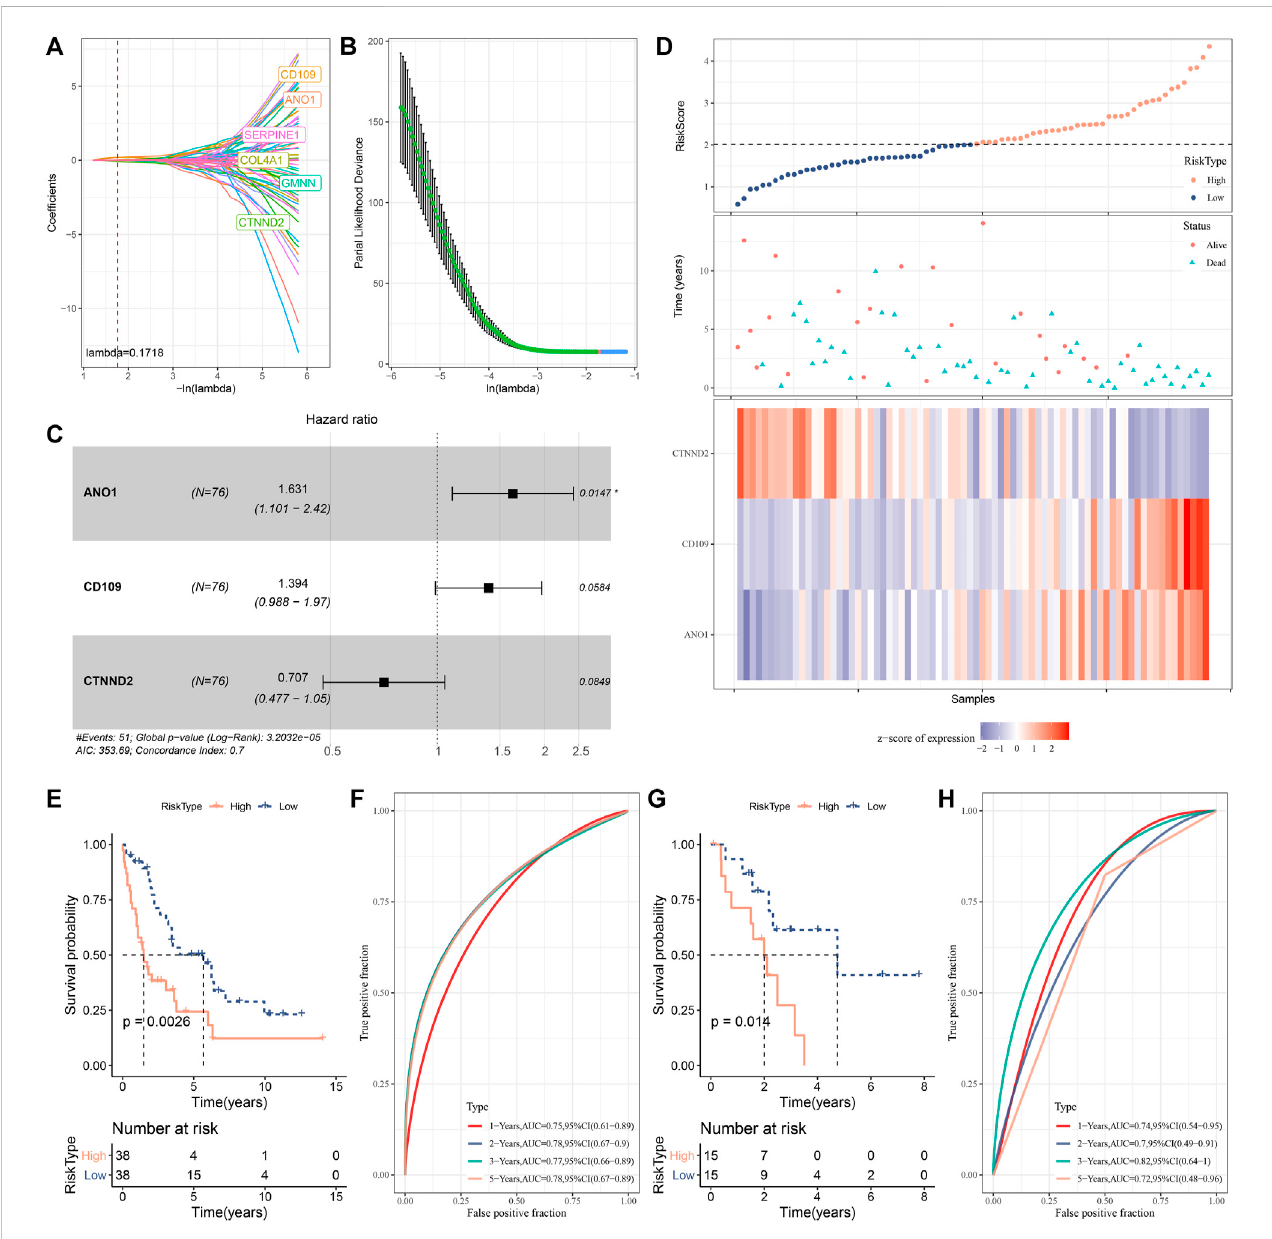
FIGURE 5 ConstructionandvalidationofanmRNAsi-relatedriskmodel. (A,B) Lassoregressiononthe98prognosticgenes.Reddashedlinein (A) andreddotin (B) represents lambda = 0.1718. (C) Three prognostic genes were screened by stepAIC. Log-rank test was conducted. (D) The risk score, survival status, and the expression of three genes of all samples in E-MTAB-6389 cohort. (E) Survival plot of high- and low-risk groups in E-MTAB-6389 cohort. (F) ROC curve of